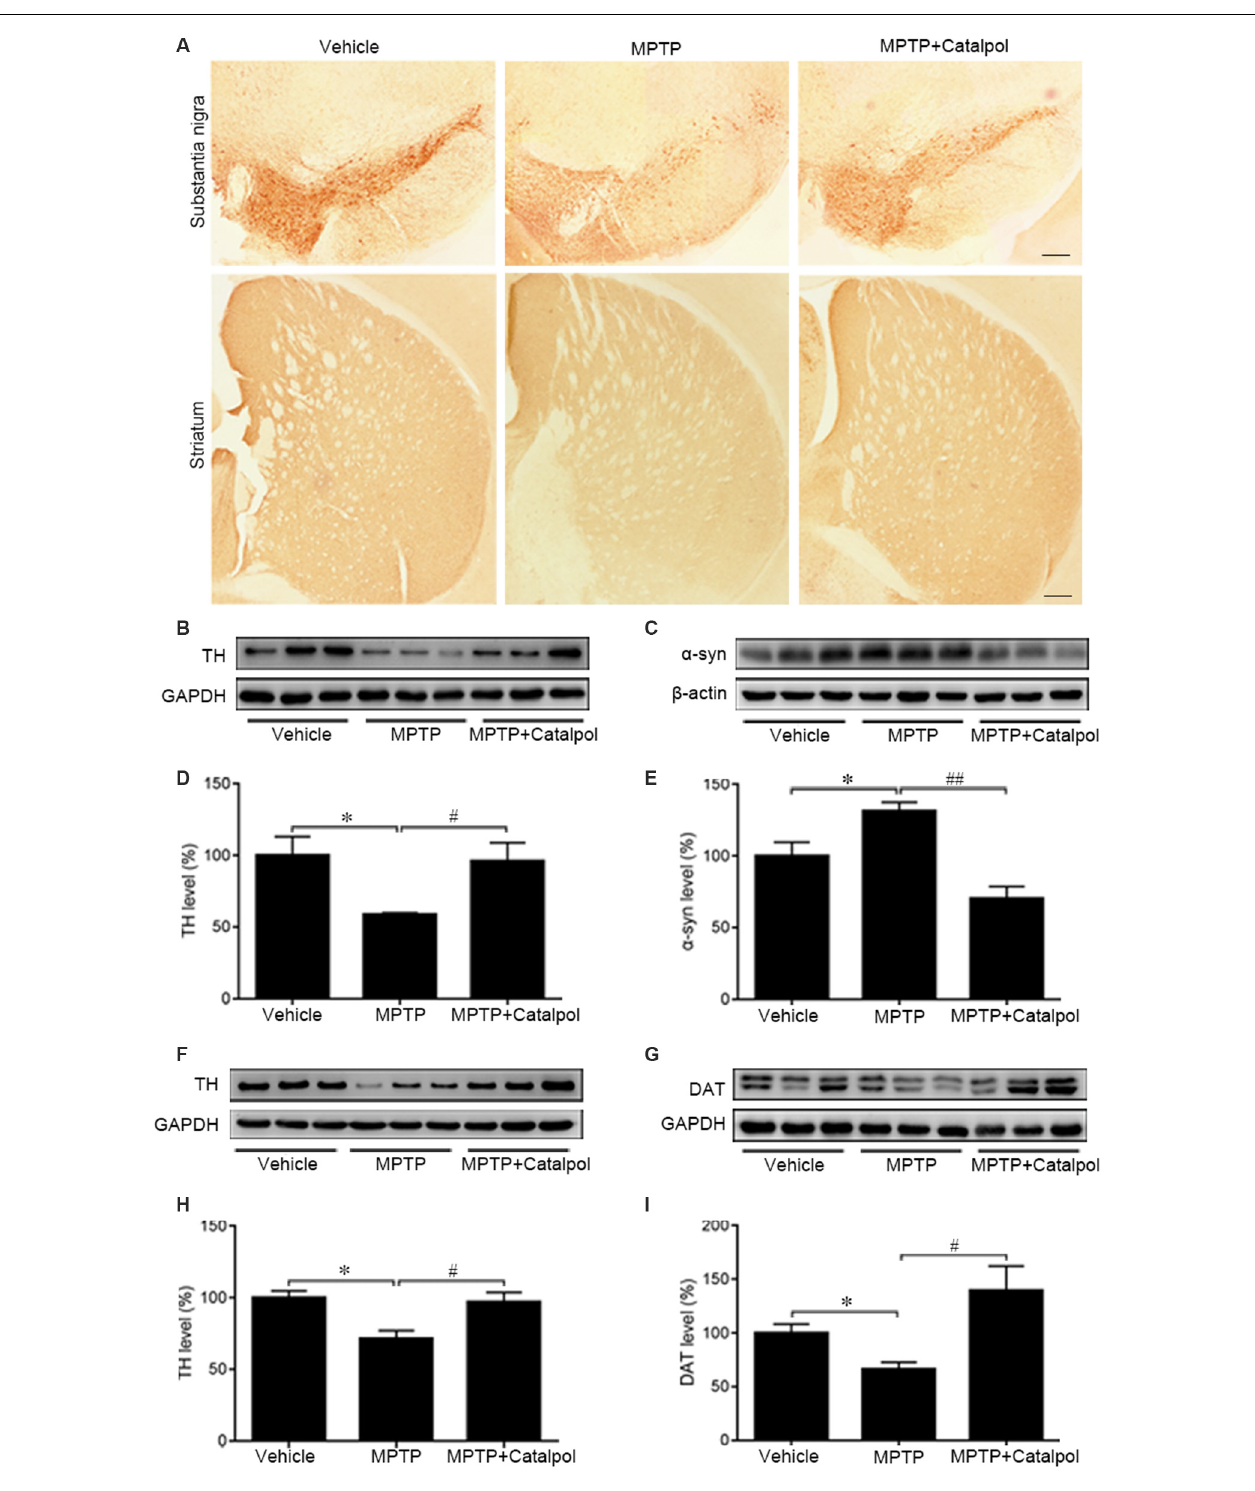
FIGURE 2 | Catalpol rescues dopaminergic (DA) neurons in the SN and striatum in an MPTP-induced mouse model of Parkinson’s disease (PD). (A) Immunohistochemical detection of tyrosine hydroxylase (TH) in DA neurons of the substantia nigra (SN) and striatum of mice treated with vehicle, MPTP, or MPTP + catalpol. Scale bar = 100 µ m. (B–E) Western blot analysis of TH and α -synuclein ( α -syn) levels in the SN. (F–I) Protein levels of TH and DA transporter (DAT) as detected by western blotting. Data represent mean ± SEM; n = 7 mice per group. The P -values were calculated using one-way ANOVA. ∗ P < 0.05 vs. vehicle group; # P < 0.05, ## P < 0.01 vs. MPTP-induced